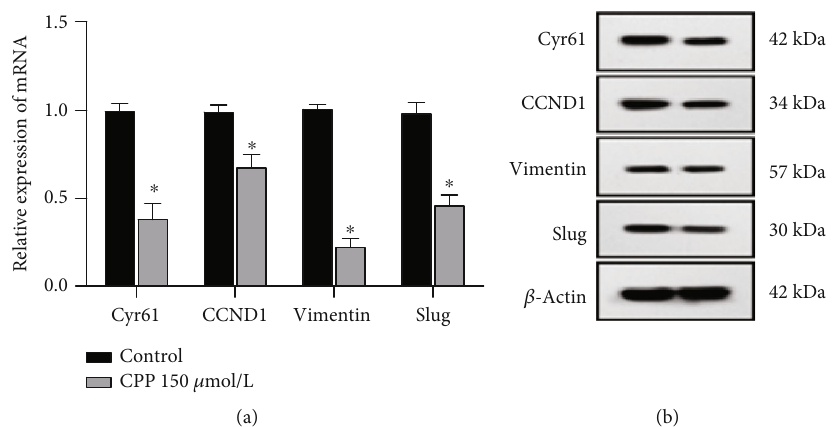
Figure 8: CPP inhibits the expression of oncogenes downstream of the GSK3 β / β -catenin signaling pathway. Compared with the control group, ∗ indicates p < 0 : 05 . This experiment was repeated three times